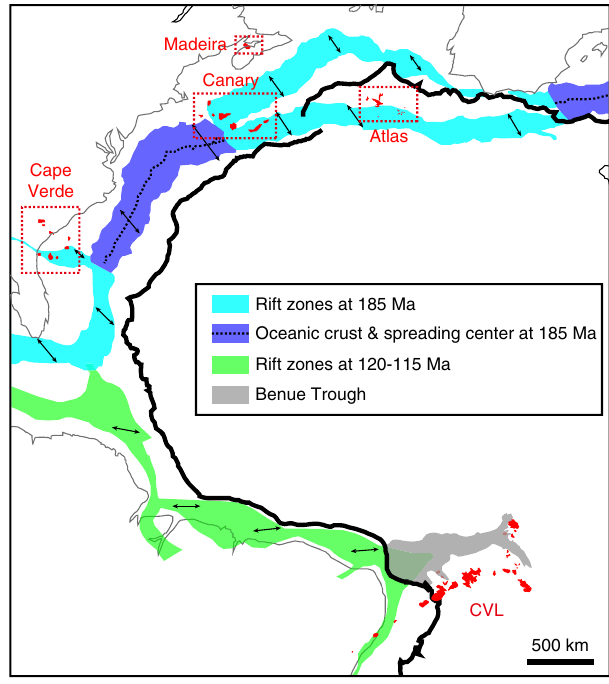
Fig. 8 The reconstructed Mesozoic rift zone of the African and South American continents and Atlantic Ocean and the locations of the West African passive margin intraplate basalts (WAPM-IB). The locations for the WAPM-IB (red) are illustrated with the current distance from the coastline of the African continent (thick black line). The rift zones are at 185 Ma 43 and 120 – 115 Ma 70 . The Benue Trough, the NW-SW rift depression initiated during the latest Jurassic to Early Cretaceous, are also